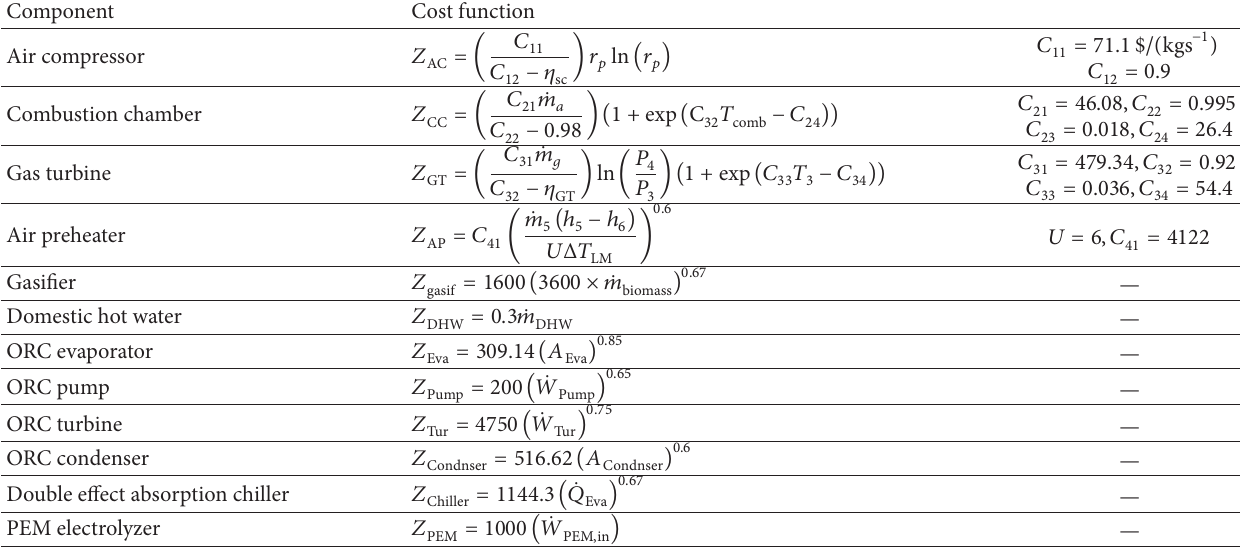
Table 2: The cost function for each composition of the multigeneration system in terms of design parameters [8, 9].